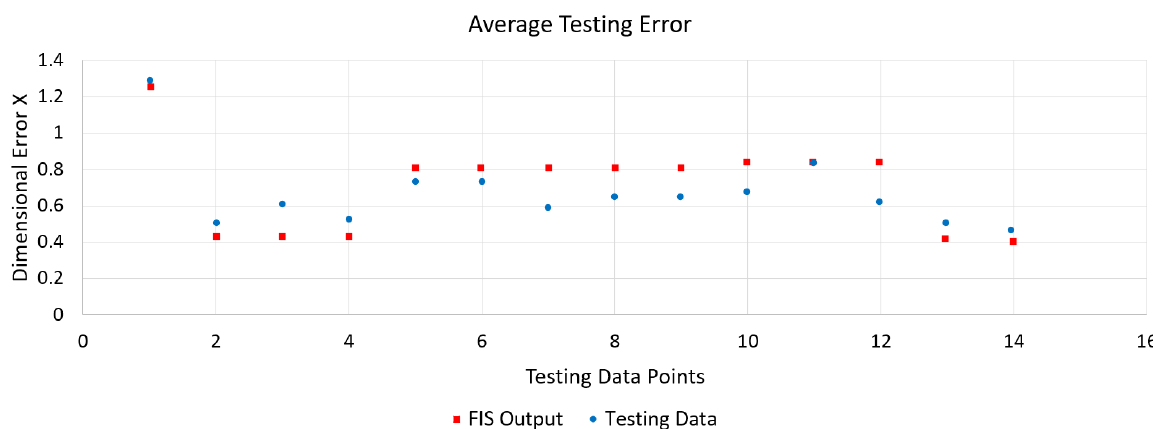
Figure 7. Average testing error for the ANFIS model for dimensional error X.